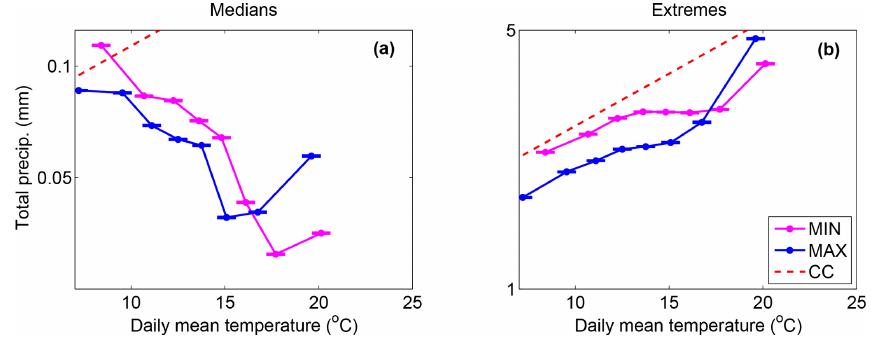
Figure 4. Hourly total precipitation as a function of daily mean temperature at the surface for median (a) and extreme (95th percentile; b ) precipitation and for both the HR MIN (magenta) and HR MAX (blue) simulations. The dashed red line indicates the CC slope calculated using the August–Magnus–Roche approximation for saturated vapour pressure. Error bars represent the 95% confidence interval of the precipitation percentiles.